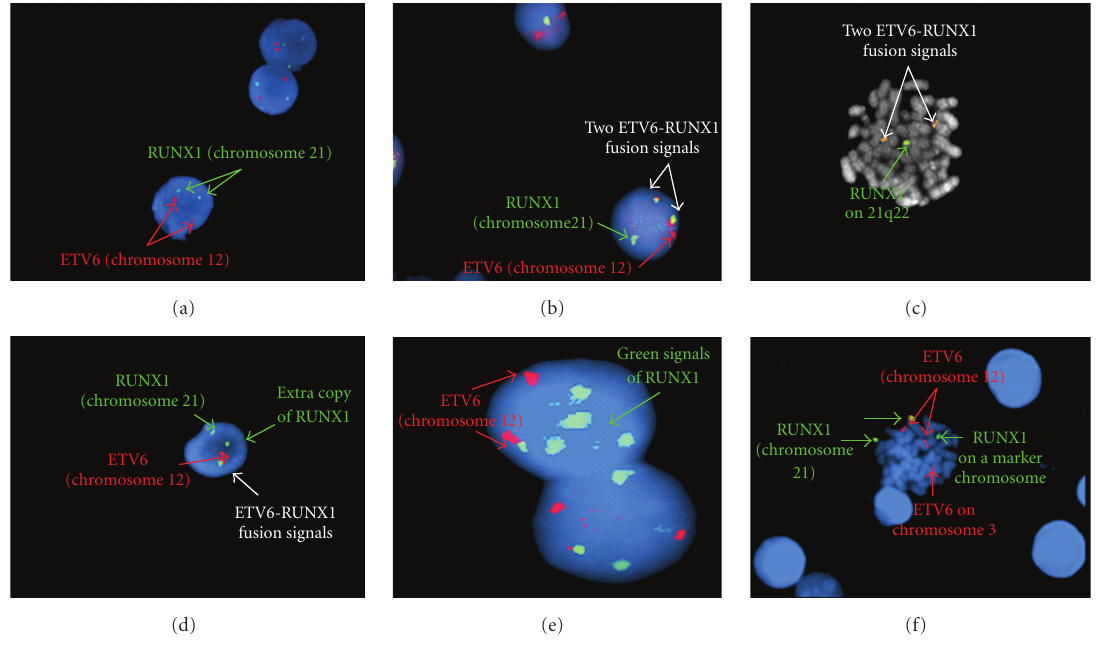
Figure 1: (a) an interphase cell with no translocation, (b) An interphase cell with two ETV6-RUNX1 fusion signals (yellow), (c) a metaphase cell with an ETV6-RUNX1 fusion signal and deletion of the second ETV6 allele (missing a red signal from the cell), (d) an interphase cell with ETV6-RUNX1 fusion signal and an extra copy of the RUNX1 gene, (e) two interphase cells with extra copies of the RUNX1 gene and without ETV6-RUNX1 fusion, (f) t(3;12) with a marker chromosome that harbored an extra copy of the RUNX1